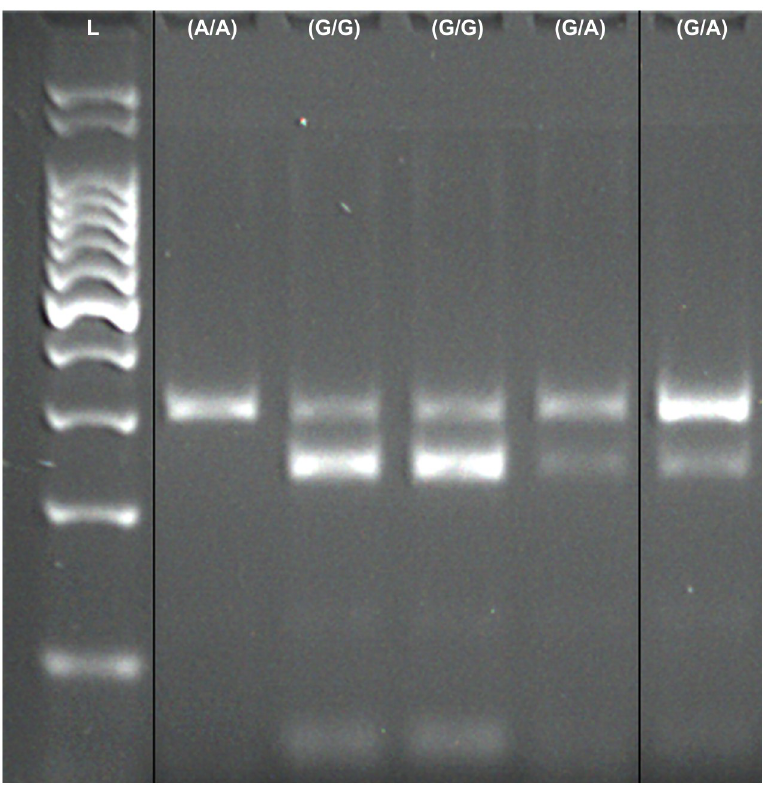
Fig 1. Electrophoretic (agarose gel) fragment patterns for SOD1 (SOD : c . 118G > A) mutation associated with CDM in German Shepherd dogs. The first lane corresponds to a 100bp ladder (Ludwig Biotecnologia LTDA). The second lane corresponds to the Swiss Shepherd dog previously confirmed as AA homozygous used as a reference in this study. The third and fourth lanes correspond to GG homozygous individuals, and the fifth and sixth lanes correspond to AG heterozygous individuals. The original image was spliced to evidence the different genotype patterns; the black vertical lines represent spliced regions. The original image is presented as S1 Fig.